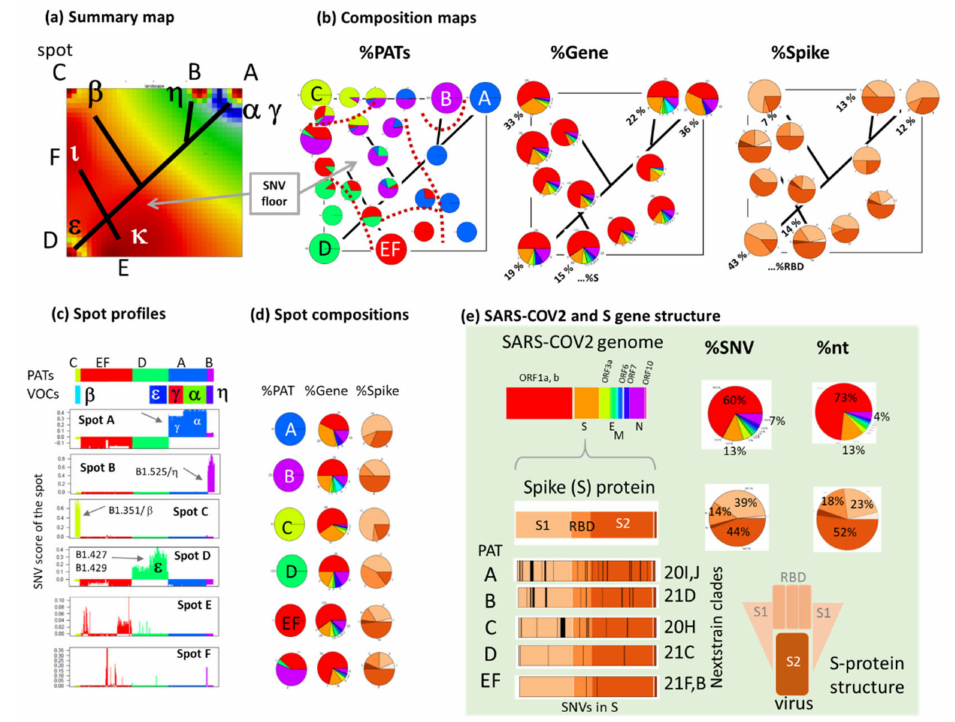
Figure 6. Cartography of the SARS-CoV-2 mutational landscape. ( a ) The summary map visualizes the mutational load across the SOM. The tree inside the SOM serves as a guide for the eye to illustrate similarity relations in analogy to the similarity tree in Figure 4b with WHO (Greek) lettering for VOCs/VOIs. ( b ) The composition maps visualize local composition SNVs regarding PATs, genes and parts of the spike gene across the SOM as pie-diagrams in units of percent. The dotted curves in the PAT-map separate regions of virtually unique PAT composition. The numbers in the %gene and %spike maps indicate percentages of the S-gene and of the receptor binding domain (RBD) in the spot areas, respectively. They vary markedly, e.g., between spot A (right upper corner) and D (left lower corner). ( c ) The spot profiles of the SNV score show the mutational load of the included SNVs across the variants. High load of the spots assigns them to the respective PATs. ( d ) The compositions of SNV regarding PATs, gene and spike region across in the different spots in analogy to part ( b ). ( e ) The legend (green background) assigns the color code for the genes, the regions of the spike protein, the distribution of mutations across the S-gene in the different PATs (SNVs are assigned in Figure A7) and the percentages of SNVs and nucleotides in the different SARS-CoV-2 genes and the S-genes. The plot of the SNV along the S-gene reflects their accumulation particularly in the spike and RBD-parts